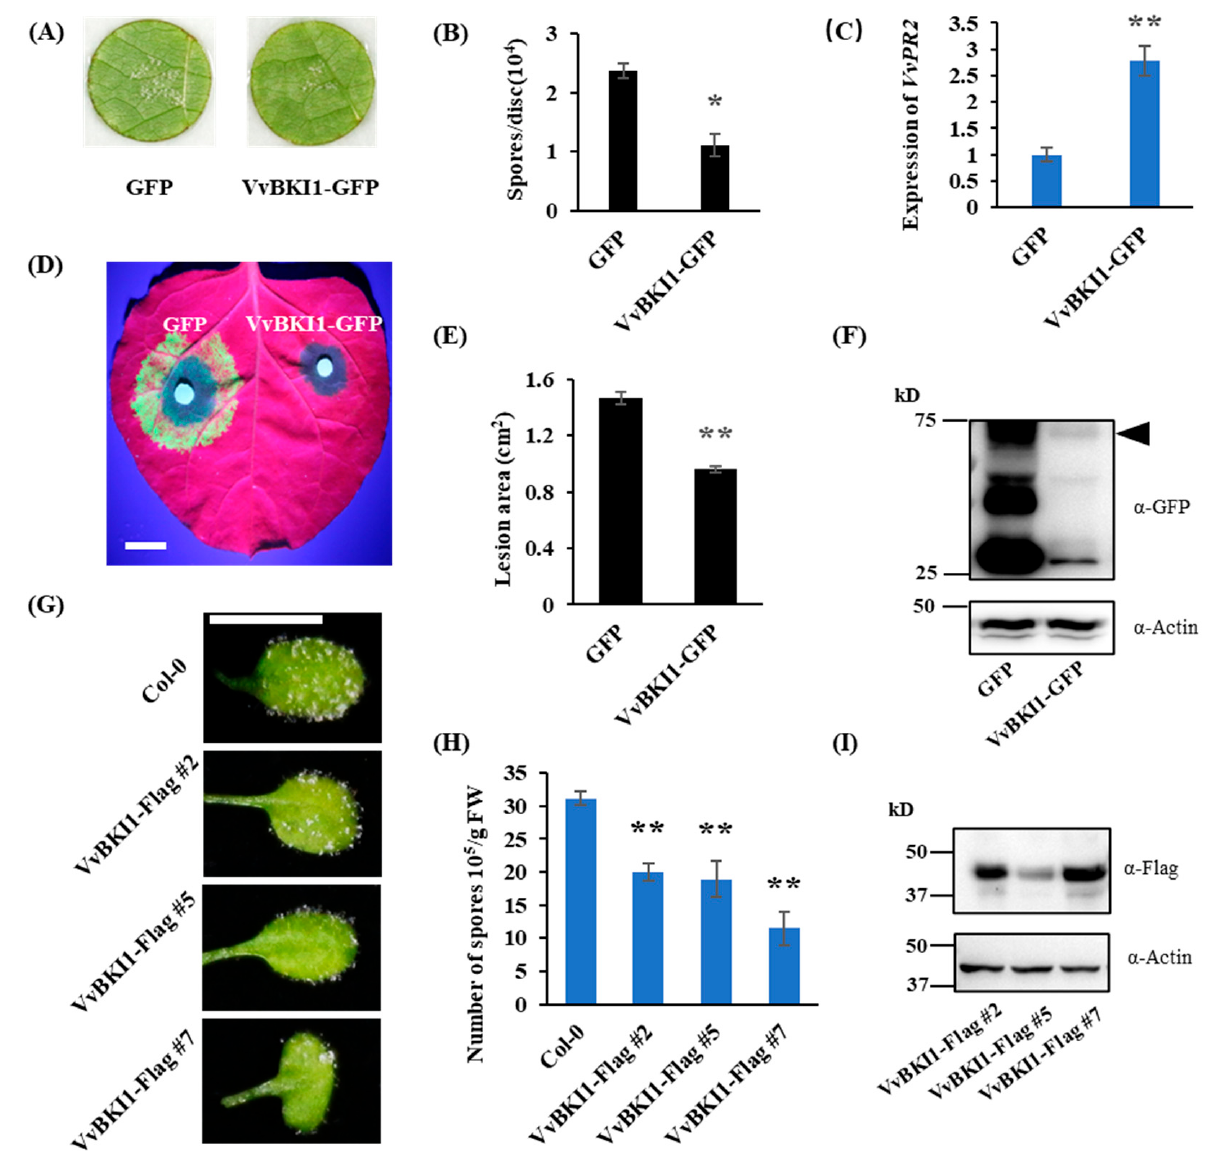
Figure 1. VvBKI1 positively regulate plant immunity. ( A , B ) Plasmopara viticola was inoculated at 4 days after agroinfiltration. Count of spores and photo were taken at 7 days after inoculation. ( C ) Expression level of pathogen-related gene PR2 at 3 dpi. ( D ) Phytophthora capsici was inoculated onto N. benthamiana leaves at 24 h after agroinfiltration. Photo was taken at 60 hpi under UV. Scale bar = 1 cm. ( E ) Lesion areas of P. capsici after transient expression of VvBKI1. Data are showed as the mean ± SD ( n = 11). ( F ) Western blot of VvBKI1 in N. benthamiana with anti-GFP antibody, at 2 days after agroinfiltration. Triangle represents VvBKI1-GFP. ( G ) Phenotype of two-week-old VvBKI1 trans- genic Arabidopsis inoculated with Hyaloperonospora arabidopsidis . Photo was taken at 4 dpi. Scale bar = 0.5 cm. ( H ) Two-week-old VvBKI1 transgenic Arabidopsis were inoculated with H. arabidopsidis . Spores were counted at 4 dpi. Data are means ± SD from 3 biological replicates. ( I ) Western blot of VvBKI1 transgenic Arabidopsis with anti-Flag antibody. * represents significant difference ( p < 0.05, Student’s t test). ** represents extremely significant difference ( p < 0.01, Student’s t test). 2.2. VvAPX1 Can Interact with VvBKI1 During investigation of the mechanism how BKI1 promoting plant resistance to oo- mycete pathogen, an immunoprecipitation–mass spectrometry (IP-MS) assay was con- ducted using N. benthamiana to find the interacting protein of BKI1. One of the proteins identified through MS assay was NbAPX1 (Niben101Scf13258g00025.1). The peptide iden- tified in IP-MS is listed in Supplementary Table S1. Given that NbAPX1 is a potential interactor of NbBKI1, and that NbAPX1 is homo- logue of VvAPX1, it is possible that VvBKI1 might interact with VvAPX1. A subsequent BiFC experiment was therefore conducted. VvBKI1 was fused with C-terminal YFP (cYFP), while VvAPX1 fused with N-terminal YFP (nYFP). VvBKI1-cYFP and nYFP-